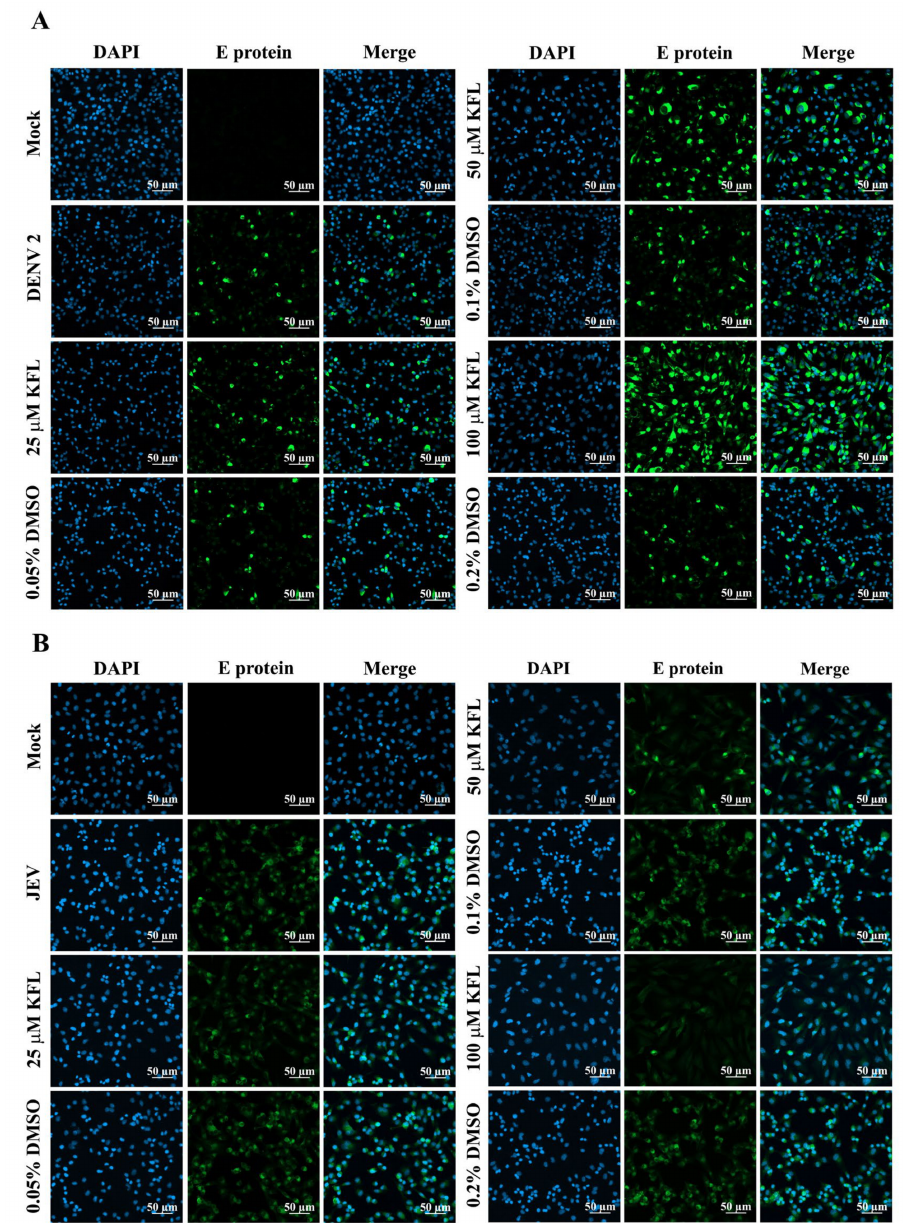
Figure 5. Evaluation of e ff ects of kaempferol by indirect immunofluorescence assay. BHK-21 cells were infected with DENV 2 ( A ) or JEV ( B ). The infected cells were incubated with various concentrations of DMSO or kaempferol for 24 h, after which cells were probed with mouse anti-dengue complex antibody ( A ) or with a mouse pan specific anti-flavivirus E protein monoclonal antibody (HB112) ( B ). Cells were counterstained with DAPI before observation under a confocal